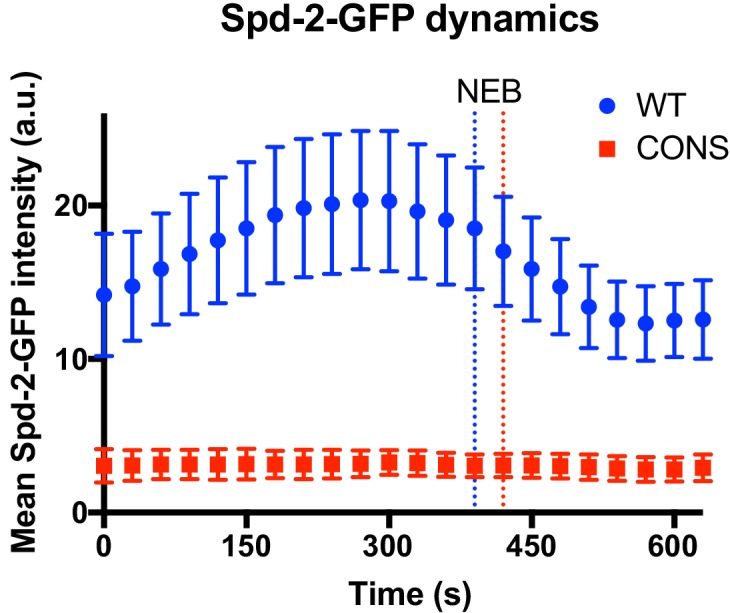
Centrosome maturation dynamics in Spd-2-CONS embryos.Graph compares the mean (± SD) centrosomal Spd-2-GFP intensity (in arbitrary units [a.u.]) through an entire embryonic cell cycle (nuclear cycle 12) in Spd-2 mutant embryos expressing either WT Spd-2-GFP (blue) or Spd-2-CONS-GFP (red); n = 155 and 75 centrosomes analysed, respectively. Time in seconds is indicated, and the time when centrosomes first separate at the start of S-phase is set as t = 0; the time of mitotic entry—scored as the time of nuclear envelope breakdown (NEB)—is indicated by the dotted vertical lines. Because the length of S-phase varies in individual embryos—384s ± 46s or 369s ± 30s (mean ± SD) for WT Spd-2-GFP and Spd-2-GFP-CONS, respectively—we cannot simply average the data at each time point from multiple embryos, so representative embryos are shown here. The analysis of all 14 WT Spd-2-GFP (blue) or Spd-2-CONS-GFP (red) embryos that were monitored in this way is shown in Figure 8—figure supplement 1 and Figure 8—figure supplement 2, respectively.10.7554/eLife.50130.036Figure 8—source data 1.Figure 8 source data, centrosomal Spd-2-GFP intensity through an entire embryonic cell cycle (embryos WT #13 and CONS #2).10.7554/eLife.50130.037Figure 8—source data 2.Figure 8, Figure 8—figure supplement 1, Figure 8—figure supplement 2 source data; centrosomal Spd-2-GFP intensity through an entire embryonic cell cycle (all the embryos).